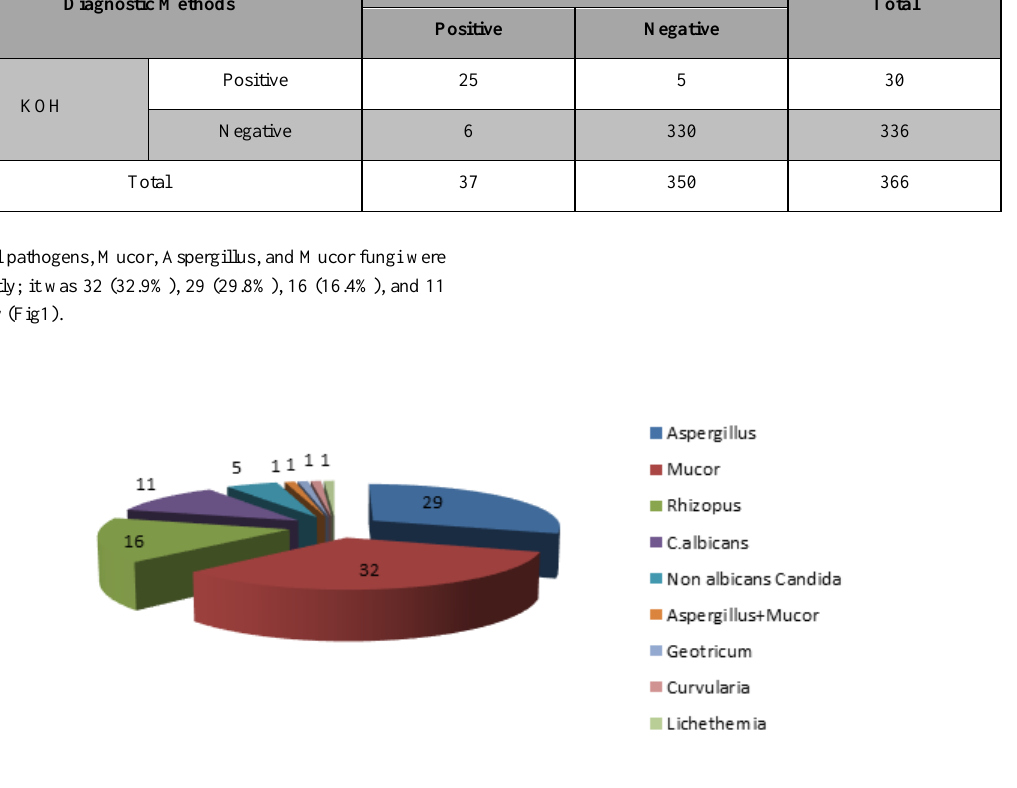
Fig 1. association of COVID-19 with fungal